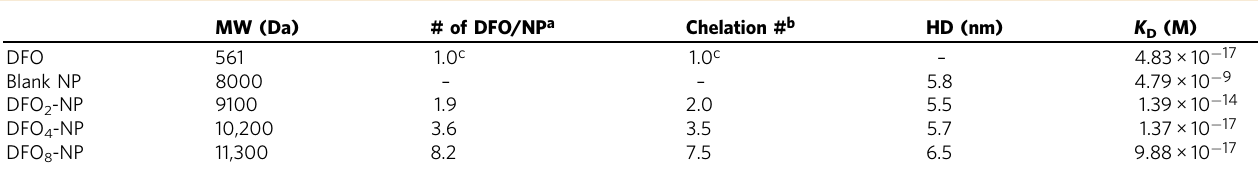
Table 1 Physicochemical characteristics of DFO-NPs